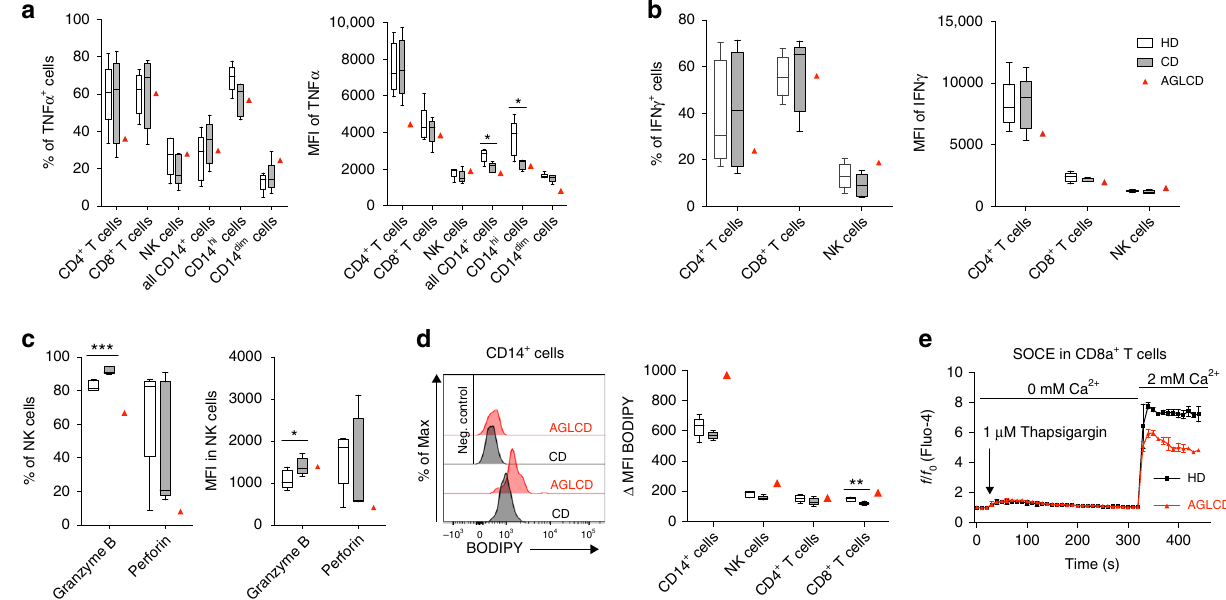
Fig. 2 Functional and metabolic alterations of immune cells in the AGLCD patient. PBMCs of the AGLCD patient, Crohn ’ s disease (CD) patients and healthy donors (HD) were compared by fl ow cytometry. a – b After ex vivo stimulation with PMA/ionomycin or LPS, the percentage of ( a ) TNF α -producing and ( b ) IFN γ -producing T, NK and monocytic cells were determined, as well as the respective mean fl uorescence intensity (MFI) serving as a measure of the amount of cytokine production (CD: n = 5, HD: n = 6 for T and NK cells; CD: n = 5, HD: n = 5 for CD14 + cells, biologically independent samples). c Unstimulated NK cells were analyzed for perforin and granzyme B expression regarding percentage of expressing cells and MFI (CD: n = 5, HD: n = 5, biologically independent samples). d Lipid droplet accumulation in immune cells was determined by BODIPY staining (CD: n = 5, HD: n = 5, biologically independent samples). e Store-operated Ca 2 + entry (SOCE) was measured in CD8 + T cells comparing AGLCD patient with HD ( n = 1, both in technical duplicates). Boxes extend from the 25th to 75th percentiles. Whisker plots show the min (smallest) and max (largest) values. The line in the box denotes the median. Error bars on the SOCE plot represent the standard deviation (SD). * P < 0.05, ** P < 0.01, *** P < 0.001, two-tailed unpaired t- test without correction for multiple comparison. The source data are provided as a Source Data fi